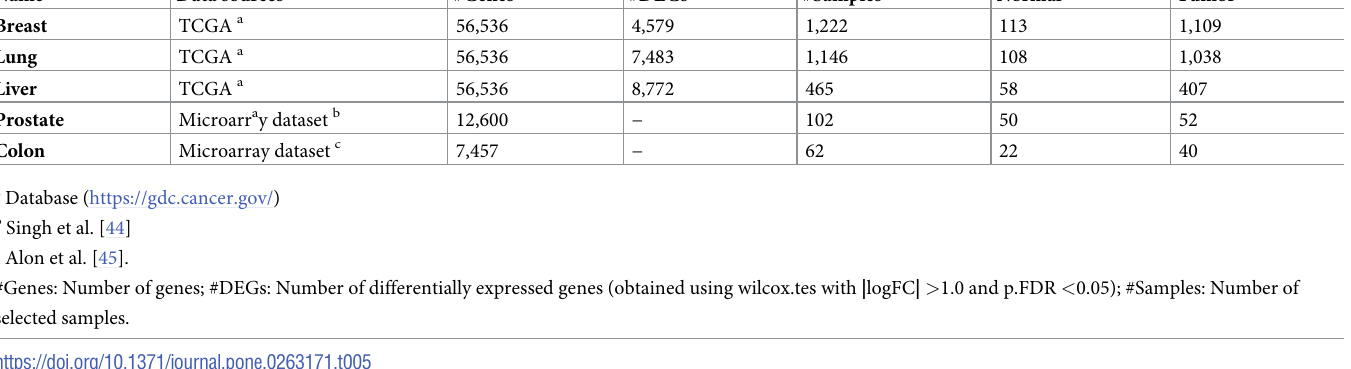
VEGF-D induces the formation of lymphatics within tumors, thereby facilitating the spread of the tumor to lymph nodes, and promotes tumor angiogenesis and growth [32–36]. TSLP is an key mediator of breast cancer progression [37–40]. Human PKMYT1 is an important regulator of the G2/M transition in the cell cycle. Studies have demonstrated that PKMYT1 might be a